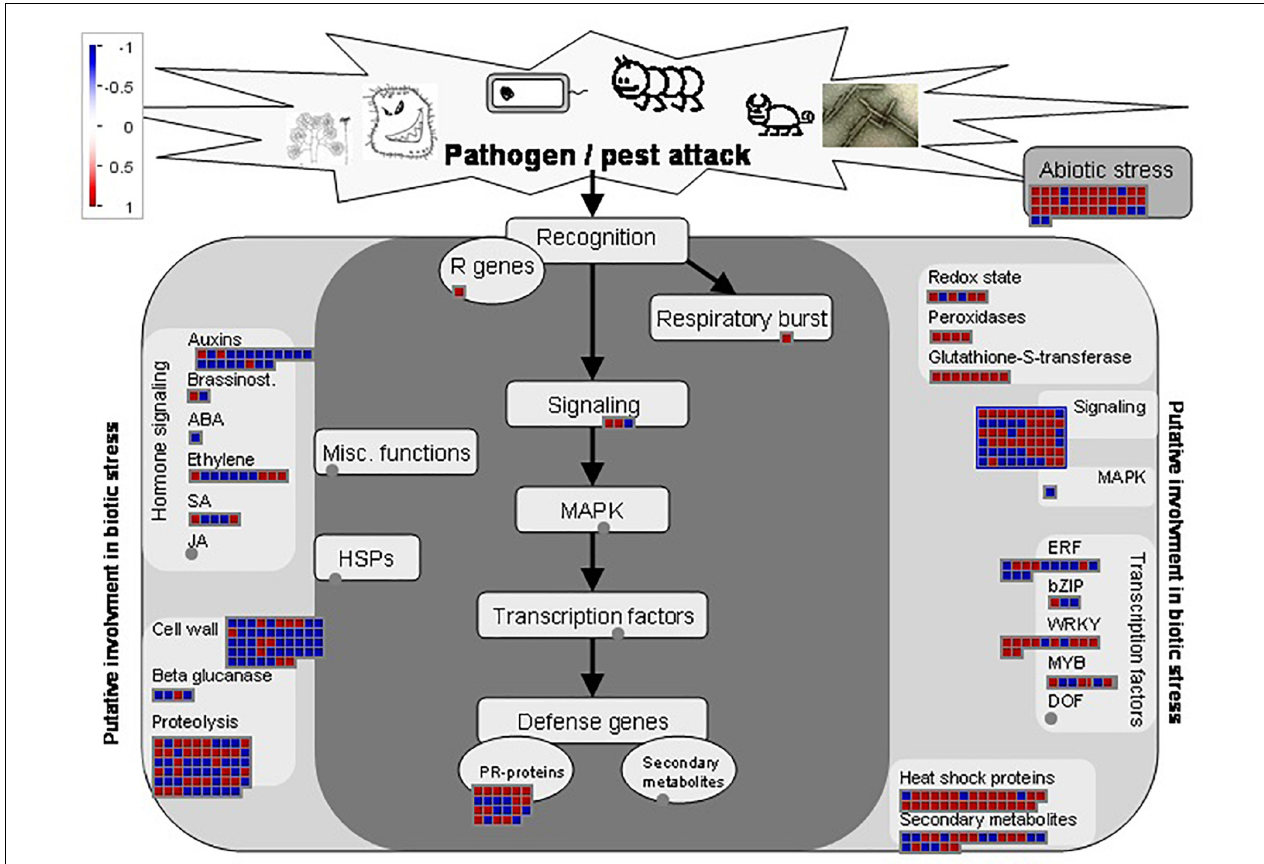
FIGURE 5 | Biotic stress overview pathway for FRh2-inoculated plants DEGs as generated by MapMan software. Red and blue boxes represent up and downregulated genes, respectively. Colour intensity represents the degree of expression given as log 2 fold change > 1 and < –1.